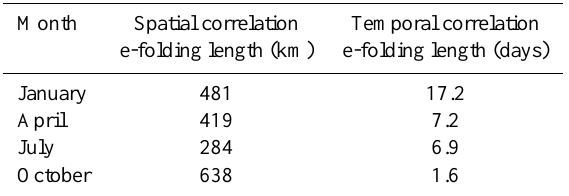
Table 1. Spatiotemporal correlation parameters